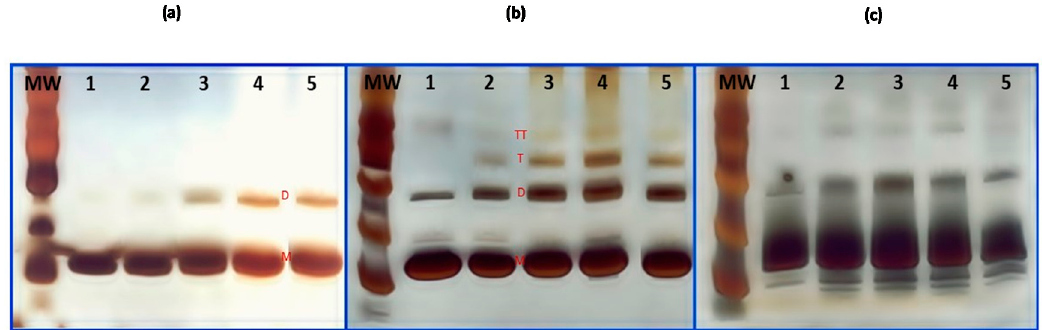
Figure 1. Sodium dodecyl sulfate-polyacrylamide gel electrophoresis (SDS-PAGE) analysis of heat-denatured and chemically-denatured of hen egg white lysozyme (HEWL). ( a ) heat-denatured HEWL at pH 6.0, lane 1: native HEWL, lane 2: HEWL/80 ◦ C, lane 3: HEWL/90 ◦ C, lane 4: HEWL/95 ◦ C, and lane 5: HEWL/120 ◦ C. ( b ) Heat-denatured HEWL at pH 7.0, lane 1: